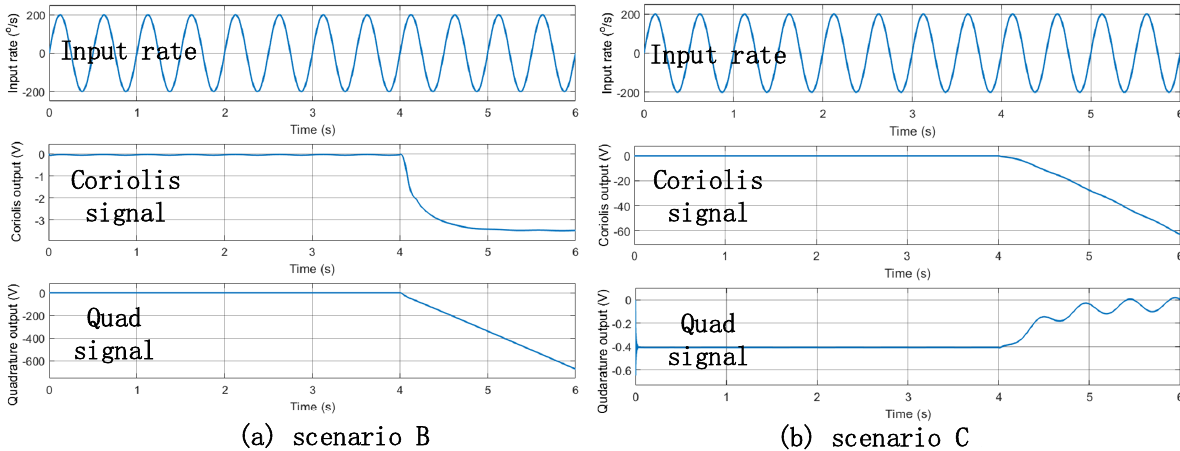
Figure 8. The simulation results under two malfunction scenarios respectively. ( a ) the simulation results under the scenario B malfunction; ( b ) the simulation results under the scenario C malfunction.